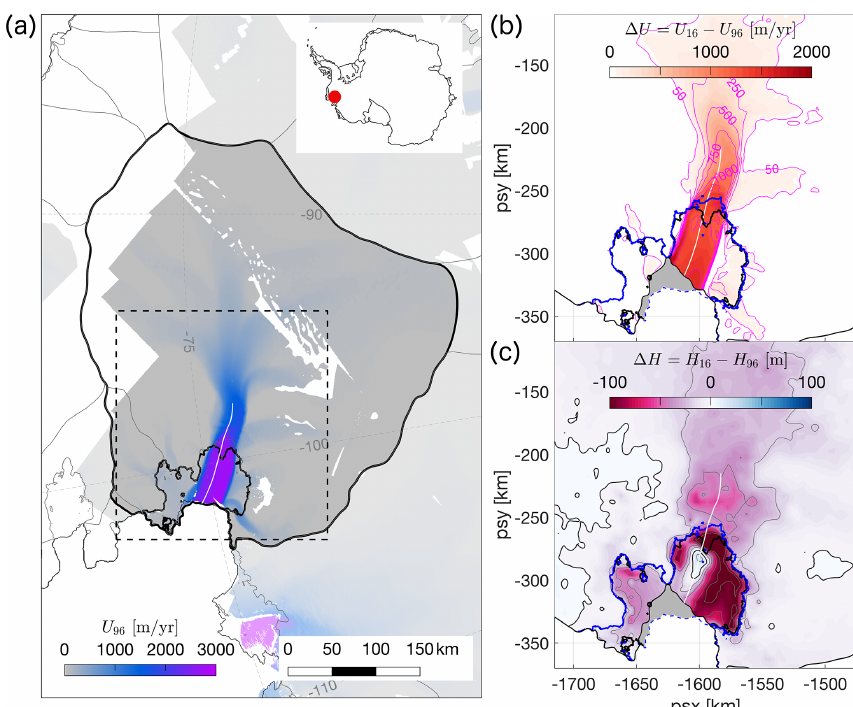
Figure 1. Pine Island Glacier (PIG) and its location in West Antarctica. (a) Surface speed of PIG in 1996 in myr − 1 , as reported by the MEaSUREs programme (Mouginot et al., 2019a). Solid black outlines delineate the extent of the PIG catchment (Rignot et al., 2011) and 1996 grounding line position (Rignot et al., 2014). The white line along the central flow line indicates the location of the transect in Fig. 2. The dashed rectangle corresponds to the extent of panels (b) and (c) . (b) Observed increase in surface speed (Mouginot et al. (2019a), colours and contours in myr − 1 and loss of ice shelf extent (grey shaded area) between 1996 and 2016. The blue line indicates the 2011 grounding line (Rignot et al., 2014). (c) Total change in ice thickness between 1996 and 2016 ( (cid:49)H in m), based on a combination of CPOM data (Shepherd et al., 2016) for the grounded ice and newly analysed data for the ice shelf (Appendix A). The zero contour is shown in black; other contours in grey are spaced at 20m